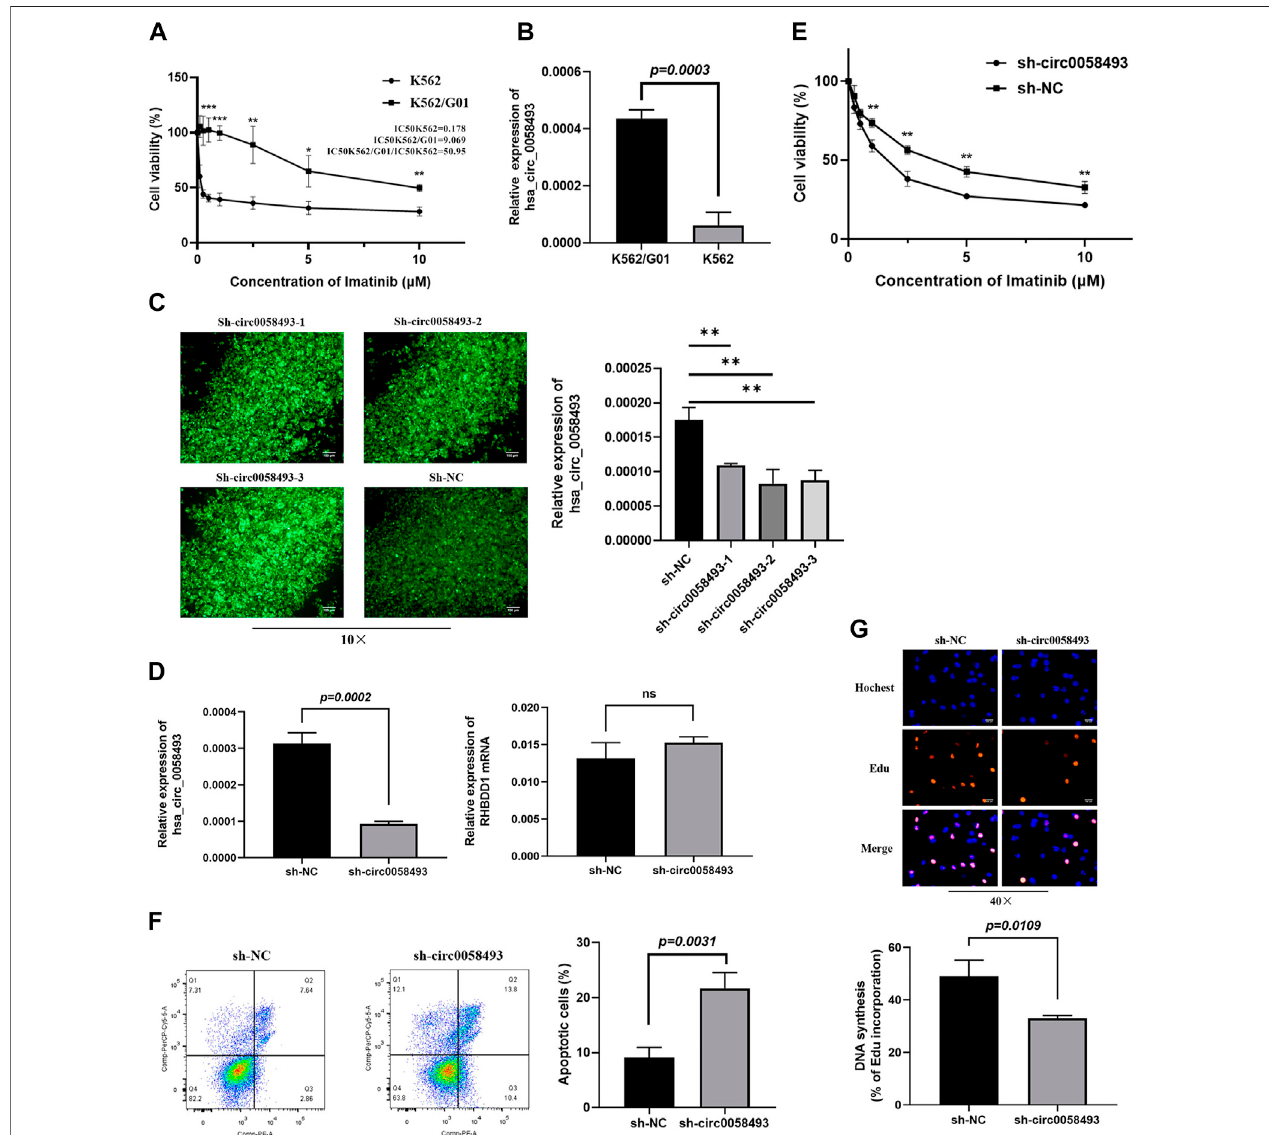
FIGURE 3 | Hsa_circ_0058493 promotes imatinib resistance in vitro . (A) The sensitivity of K562 and K562/G01 to imatinib. (B) circ_0058493 was signi fi cantly upregulated in K562/G01 compared with K562 ( p (cid:1) 0.0003). (C) Fluorescence images of K562/G01 cells after transfected with sh-circ0058493-1, sh-circ0058493-2, sh-circ0058493-3,andsh-NC;RT-qPCRshowedthatallthethreesh-circ0058493hadthesigni fi cantinterferenceef fi ciencyagainstcirc0058493. (D) sh-circ_0058493 was transfected into K562/G01 by lentivirus and obviously downregulated the level of circ_0058493 ( p (cid:1) 0.0002), while the expression level of RHBDD1 wasn ’ t affected by sh-circ_0058493. (E) CCK-8 experiment showed the cell viability of K562/G01 was obviously inhibited at different IM concentrations after circ_0058493 downregulation. (F) Flow cytometric assay showed the apoptosis rate of K562/G01 cells was obviously increased after circ_0058493 downregulation ( p (cid:1) 0.0031). (G) EdU experiment showed the proliferation ability ofK562/G01cells was obviously inhibited after circ_0058493 downregulation ( p (cid:1) 0.0109). Quantitative data from three independent experiments are shown as the mean ± SD (error bars). * p < 0.05, ** p < 0.01, *** p < 0.001, ns: not statistically signi fi cant (Student ’ s t -test).